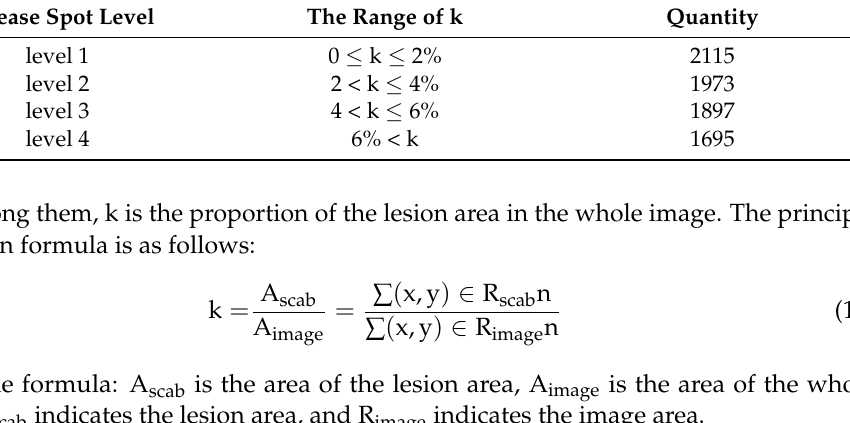
Table 2. Grading table of Disease Spots on Maple Leaves. Disease Spot Level The Range of k Quantity level